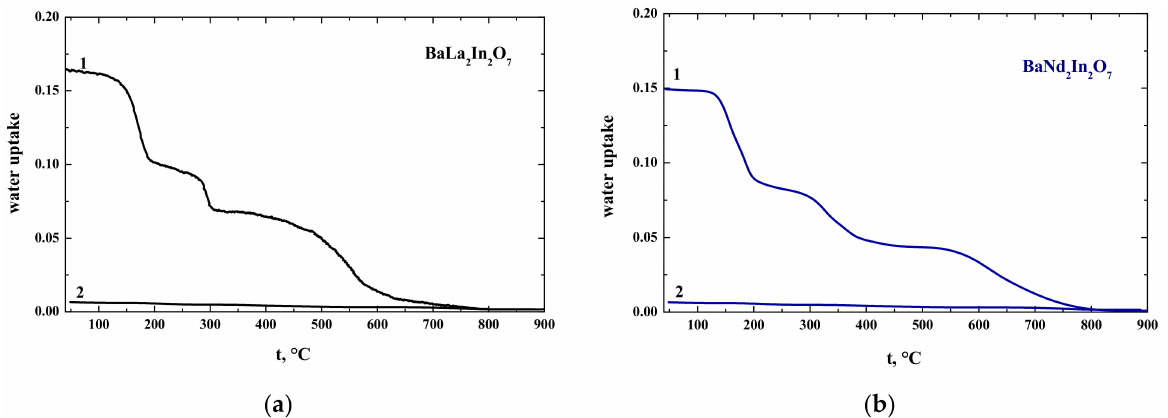
Figure 6. Thermogravimetry data for the BaLa 2 In 2 O 7 ( a ) and BaNd 2 In 2 O 7 ( b ) compounds obtained under wet (1) and dry (2)